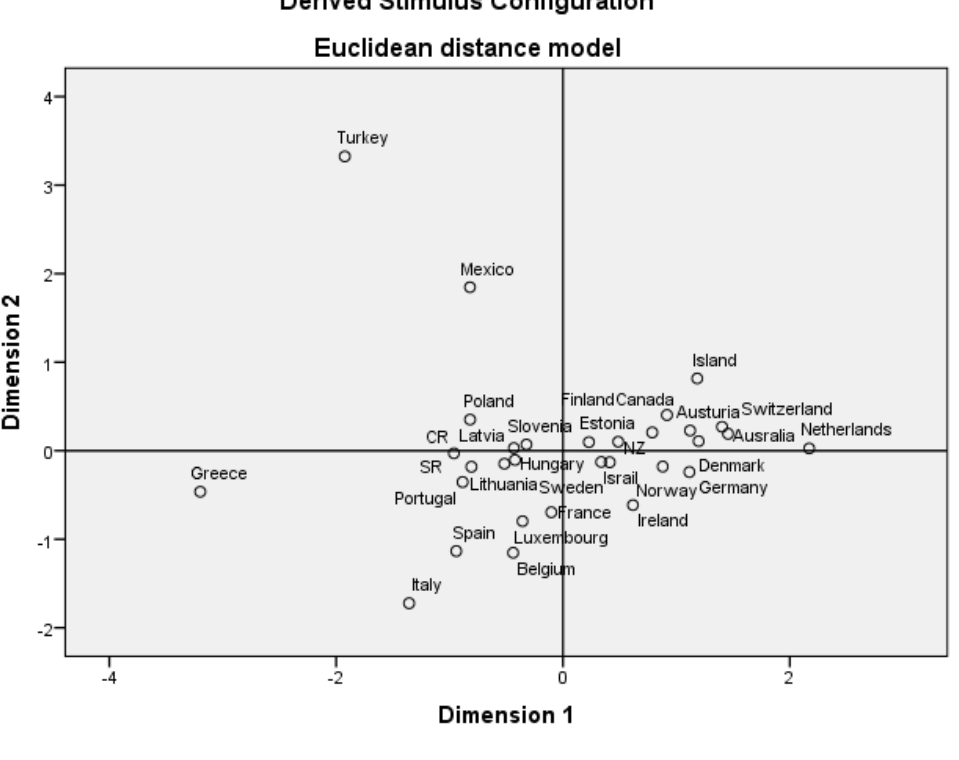
Figure 1: Euclidean distance